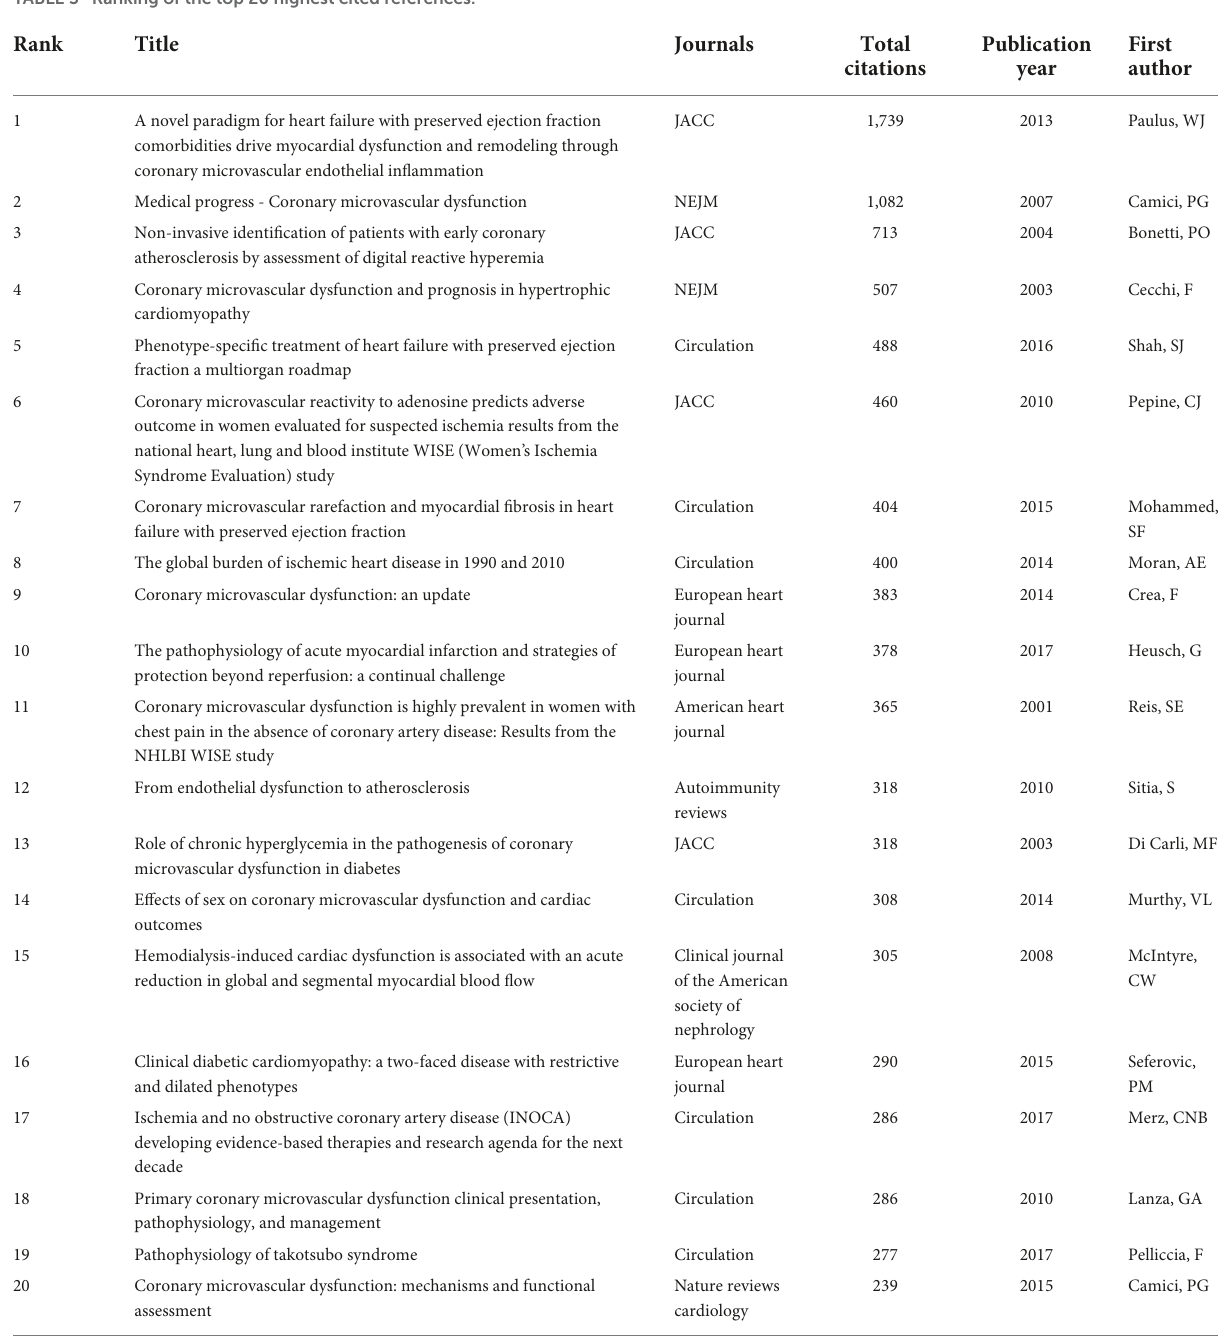
TABLE 3 Ranking of the top 20 highest cited